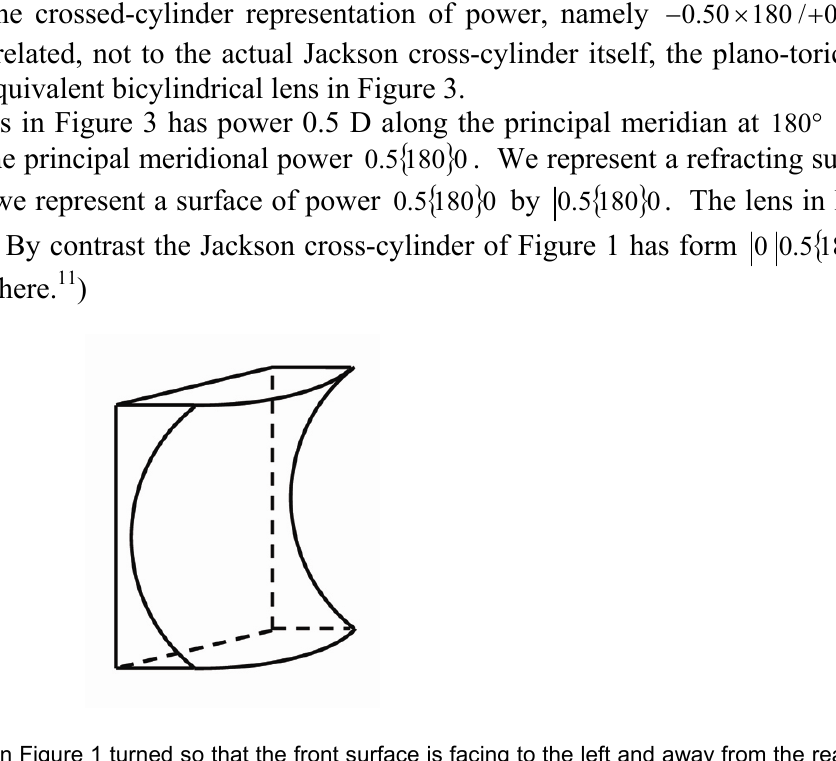
Figure 2 Representation of the lens in Figure 1 turned so that the front surface is facing to the left and away from the reader. The lens is now shown as cut square. The surface curvatures are greatly exaggerated. The reader is looking directly at the back surface and can see the front surface through the lens. The front surface is flat; the back surface is saddle-shaped. The lens has form { } − 0 0.5 180 0.5 .